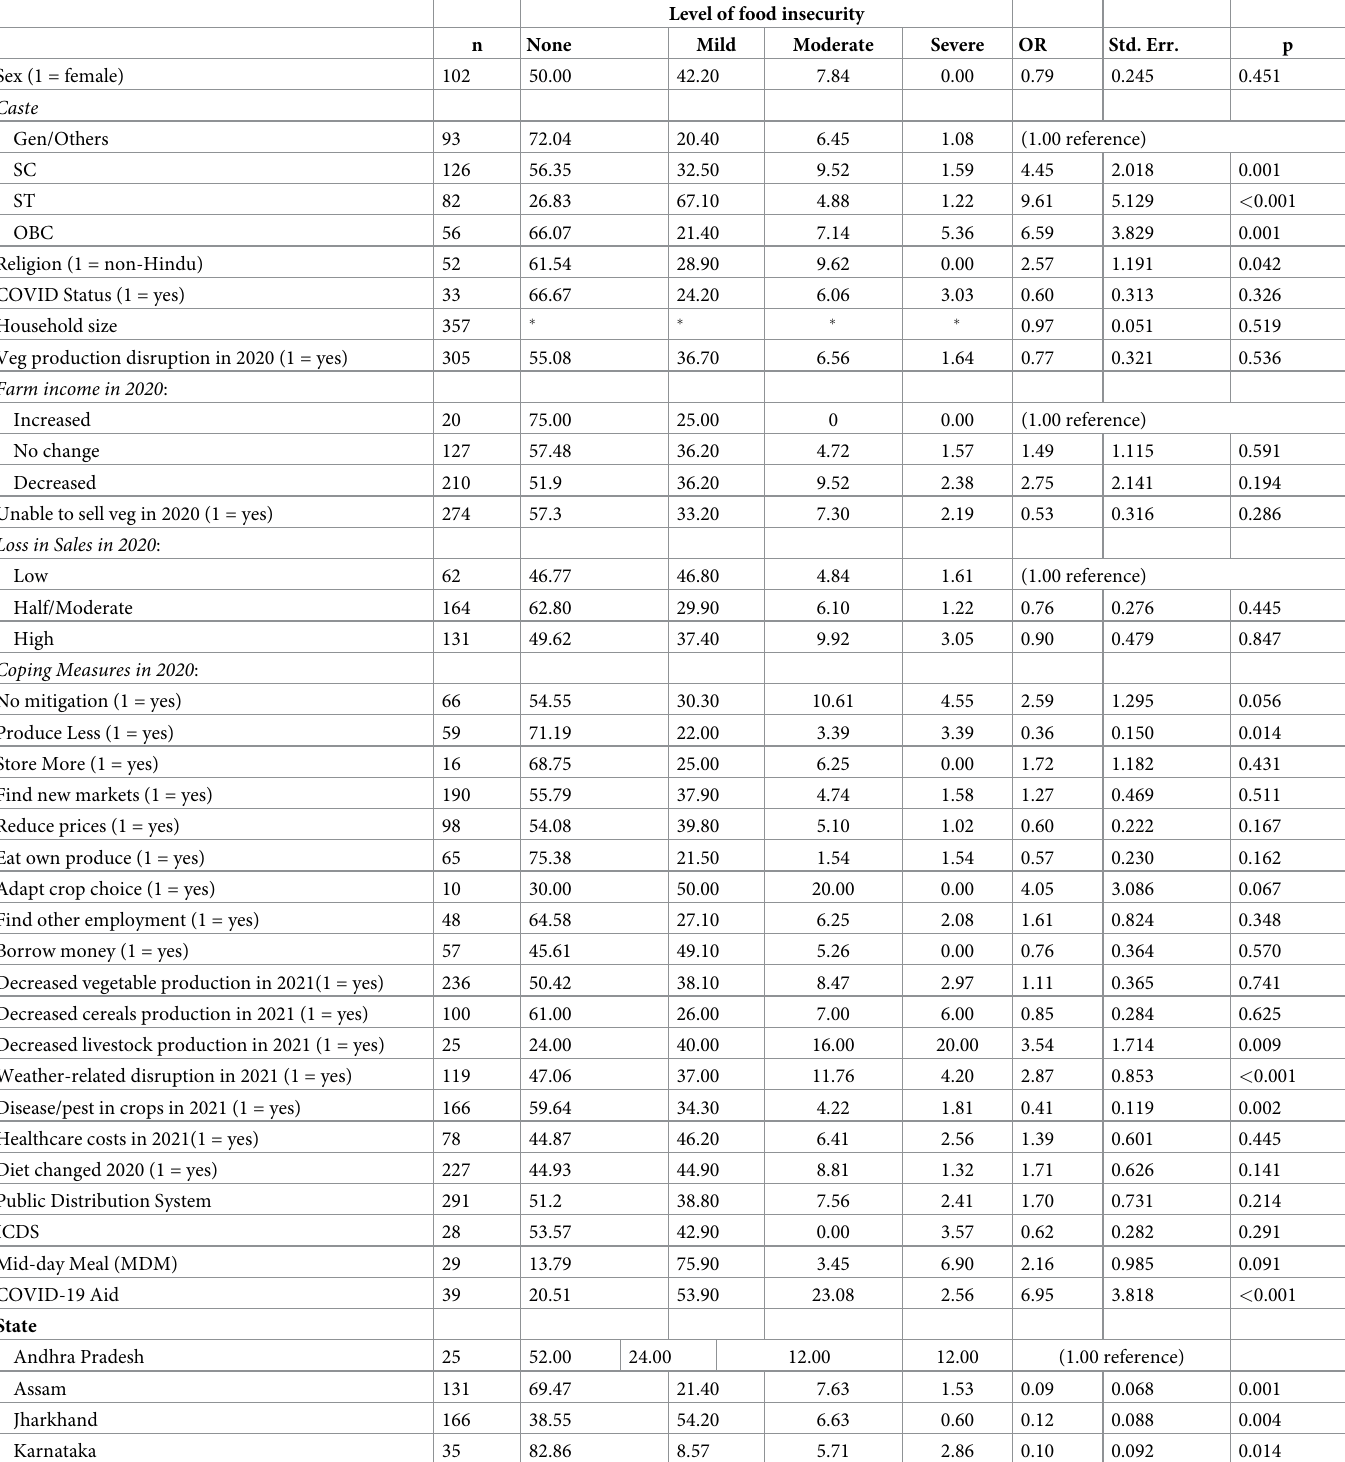
Table 5. Factors associated with food insecurity among farmers across both survey rounds. Level of food insecurity n None Mild Moderate Severe OR Std.